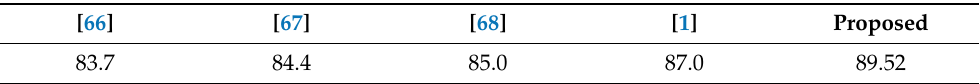
Figure 8. Illustration of the proposed deep learning model for automatic tuberculosis screening in chest X-ray images. The architecture is based on EfficientNetV2 [44] model. Table 5. Performance analysis of the proposed deep learning model in terms of classification accuracy (%) on Shenzhen dataset with comparison of existing